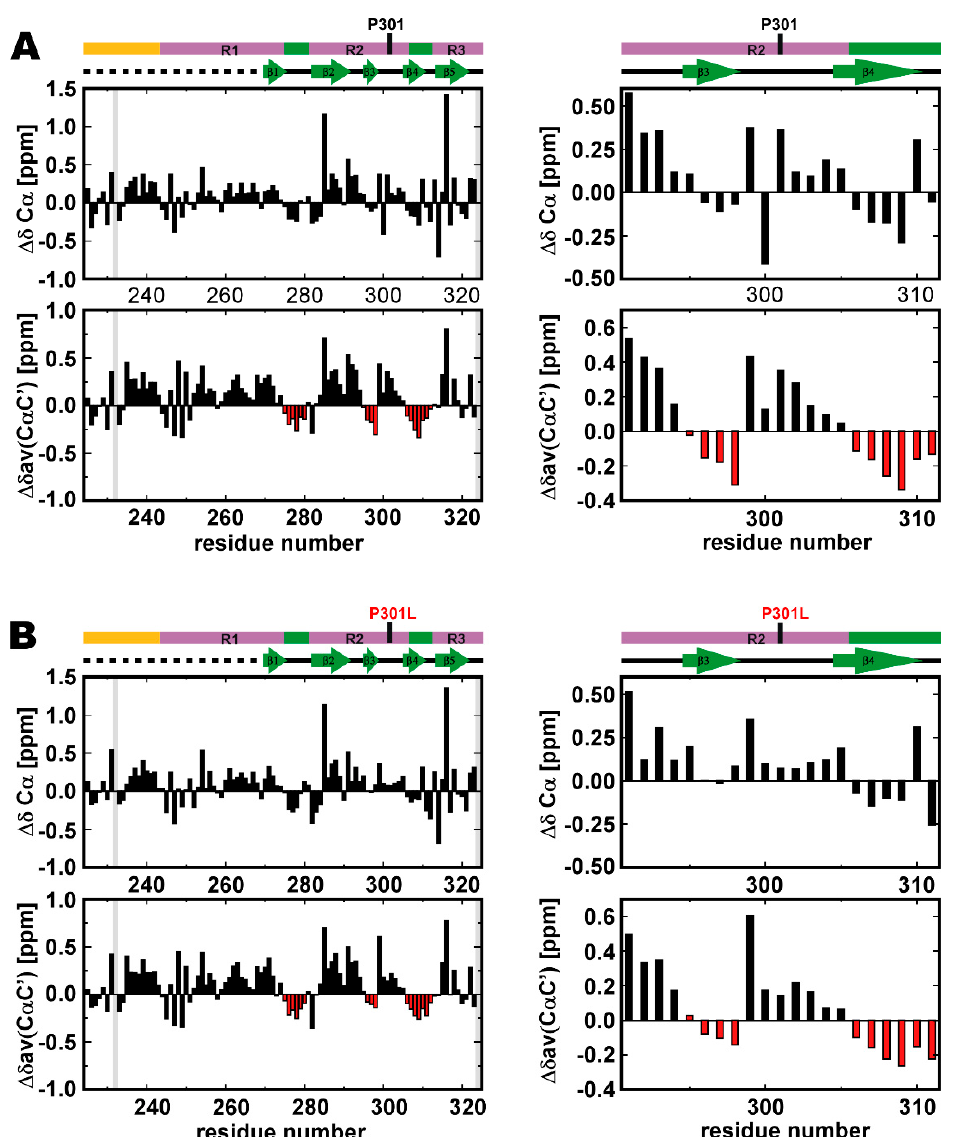
Figure 3. Secondary chemical shifts of TauF4 Δ . ( A ) Secondary chemical shifts for 13 C α , Δδ C α and the averaged secondary chemical shifts for 13 C α and 13 C’, Δδ av (C α C’), for the wild-type are shown in the left panels. The expanded plots around the mutation site, P301, are placed in the right panels. The averaged secondary chemical shits are calculated as [3 Δδ C α + 4 Δδ C’]/7 [25]. Regions showing β - structure propensity are identified by negative Δδ av (C α C’) values that extend over several residues and are marked in red. ( B ) The secondary chemical shifts Δδ C α and Δδ av (C α C’) for the P301L mutant are presented. The gray bar represents the residue did not show a resolved signal.